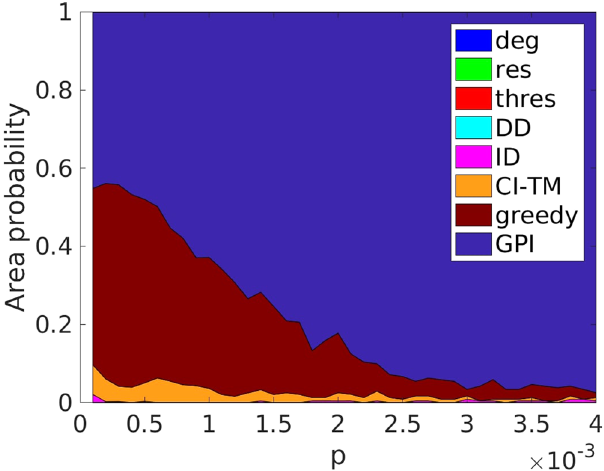
Figure 4. Probability of each strategy being the best strategy for one network with N = 10,000, 〈 k 〉 = 10, ρ = 0, σ = 0.2887, and φ = . 0 5 , for 240 threshold generations (same for each